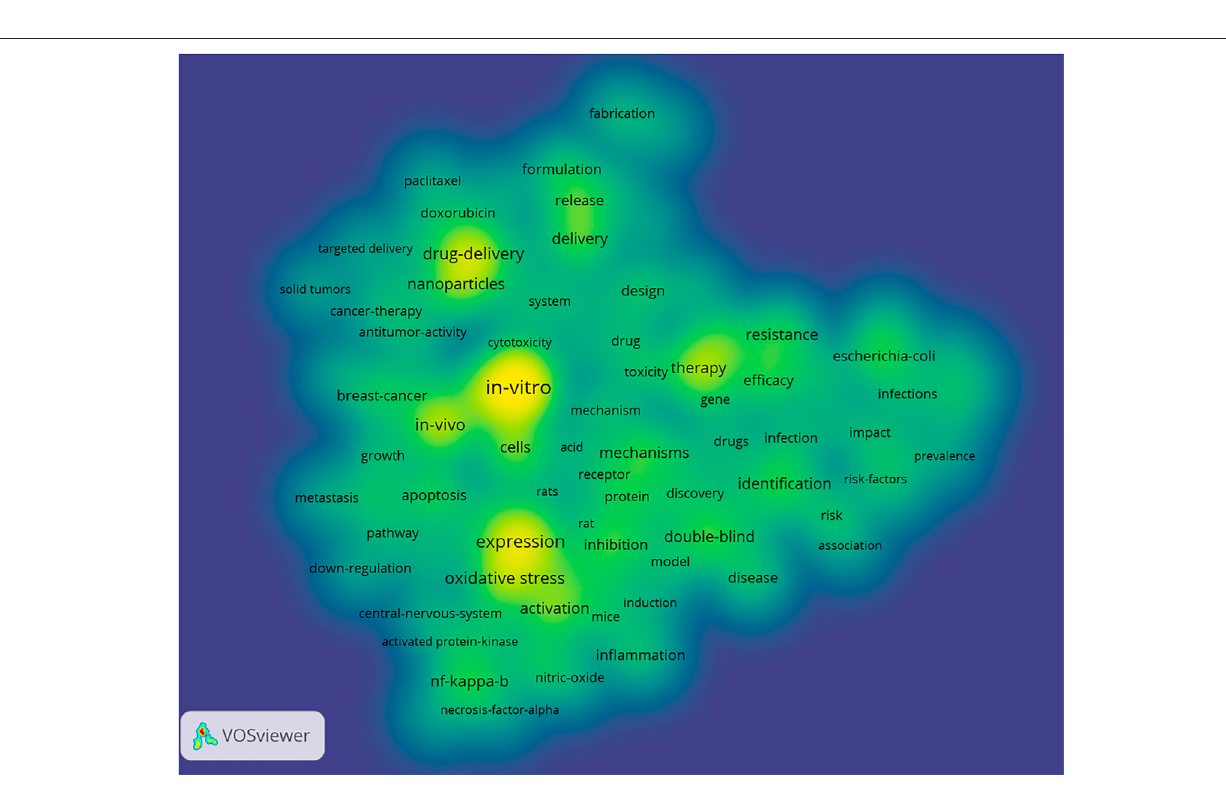
Frontiers in Pharmacology |